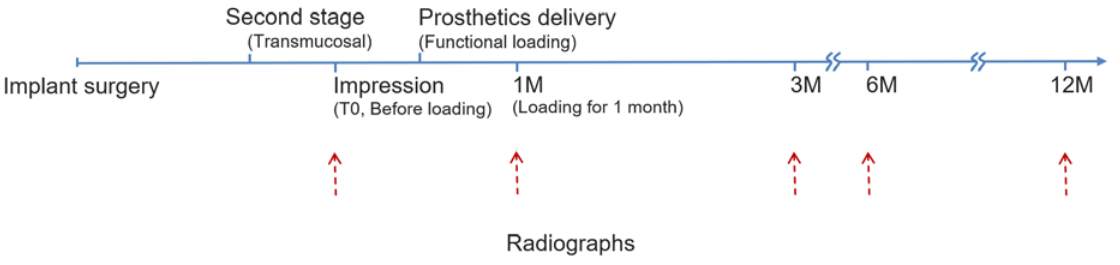
Figure 1. Flow Figure 1. Flow chart .